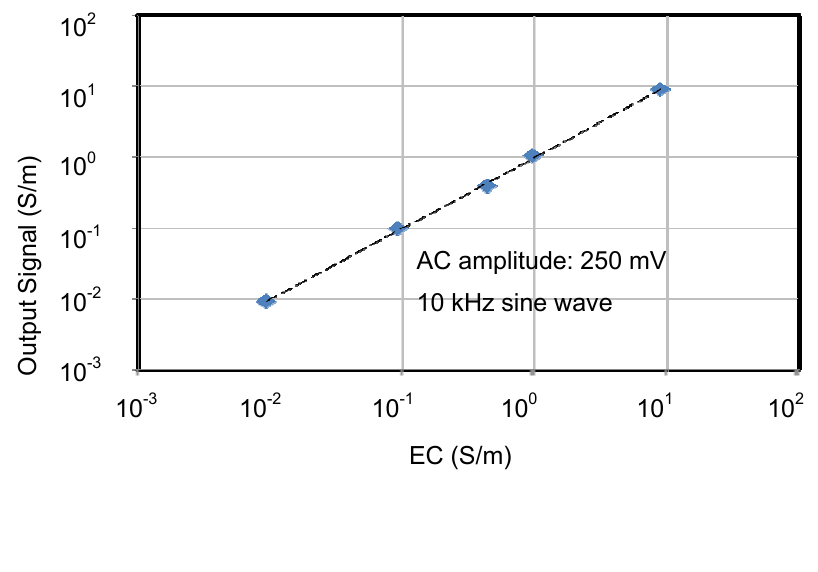
Figure 7. Characteristics of EC sensing area. The operating range is wide enough for use in